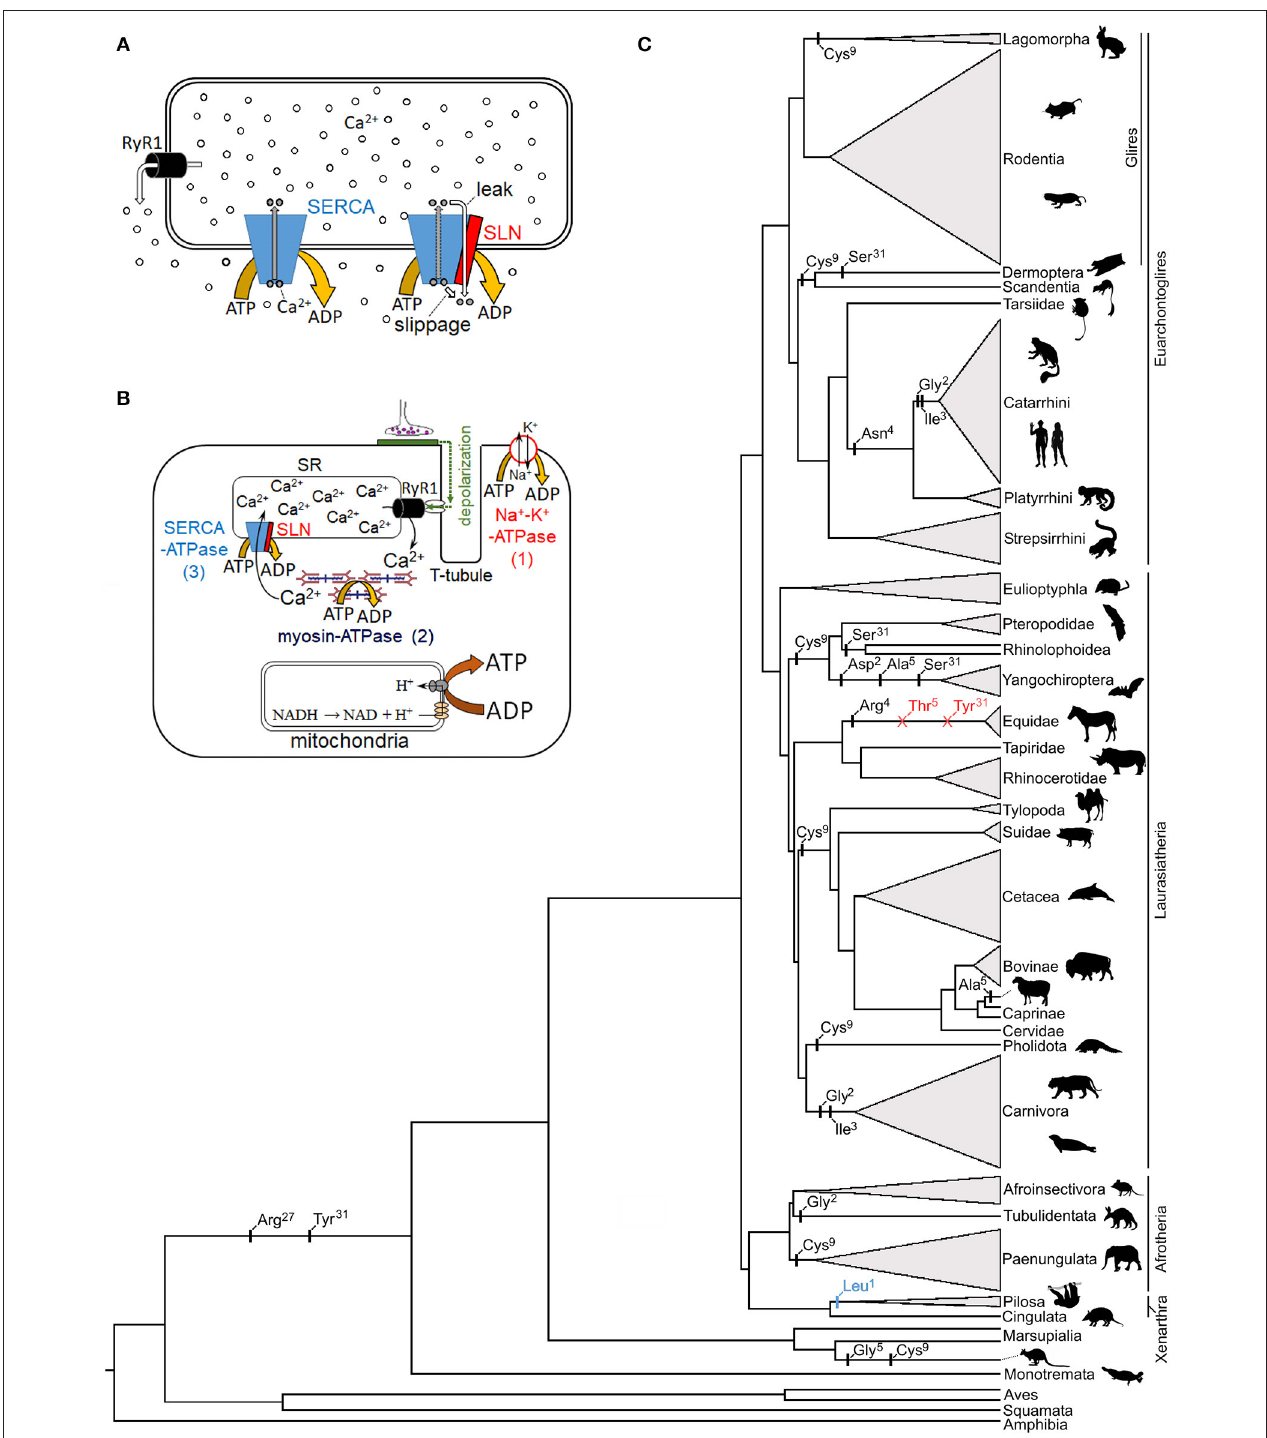
FIGURE 1 | Proposed mechanism of sarcolipin in skeletal muscle non-shivering thermogenesis, and its genetic evolution . (A) The two functional mechanisms by which SLN is postulated to return SERCA-bound Ca 2 + to the cytosol following ATP hydrolysis: enzyme slippage and passive leak ( right complex ). (B) Primary mechanisms of ATP hydrolysis in a typical skeletal muscle fiber following a nervous stimulation: (1) Na + -K + -ATPase, (2) myosin-ATPase, and (3) SERCA Ca 2 + -ATPase. Note that while some heat is liberated by these ATPases, most muscle thermogenesis is via mitochondrial catabolic processes which generate the proton motive force required for ATP synthesis. (C) Mammalian phylogenetic tree denoting potentially relevant SLN residue substitutions (black), start codon mutations (blue), and deletions (red)